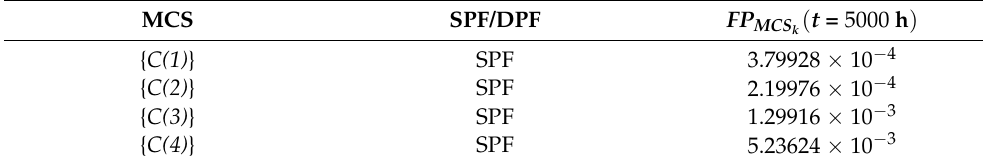
Table 3. List of MCSs and their failure